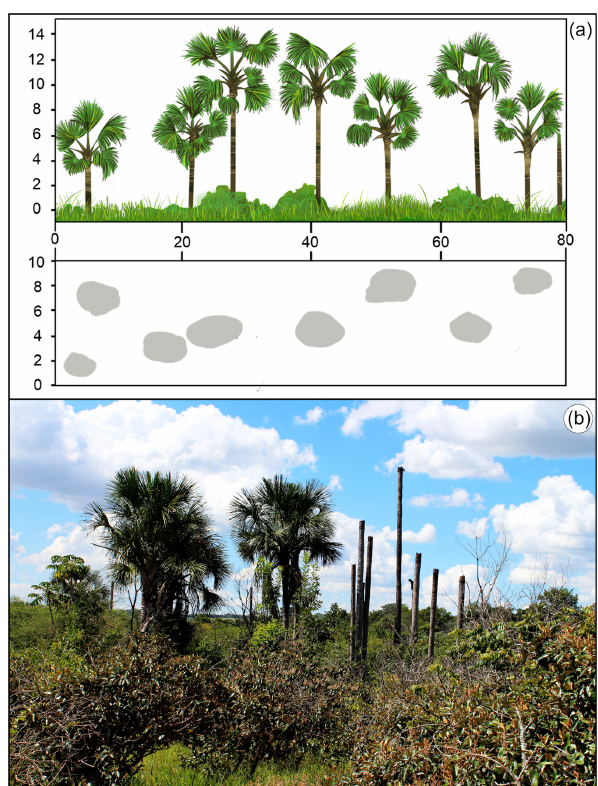
Figure 2. Vereda palm swamp formation ( a ; average height: 12– 15m, tree cover: 5%–10%). Vereda of the PES with the outstanding presence of the buriti palm ( Mauritia flexuosa ) in permanent wet soil. Dead palm trees and Miconia albicans invasive shrubs (typical of savanna formations) evince structural changes and wood plant encroachment (WPE) in the Vereda surrounding areas (b) .